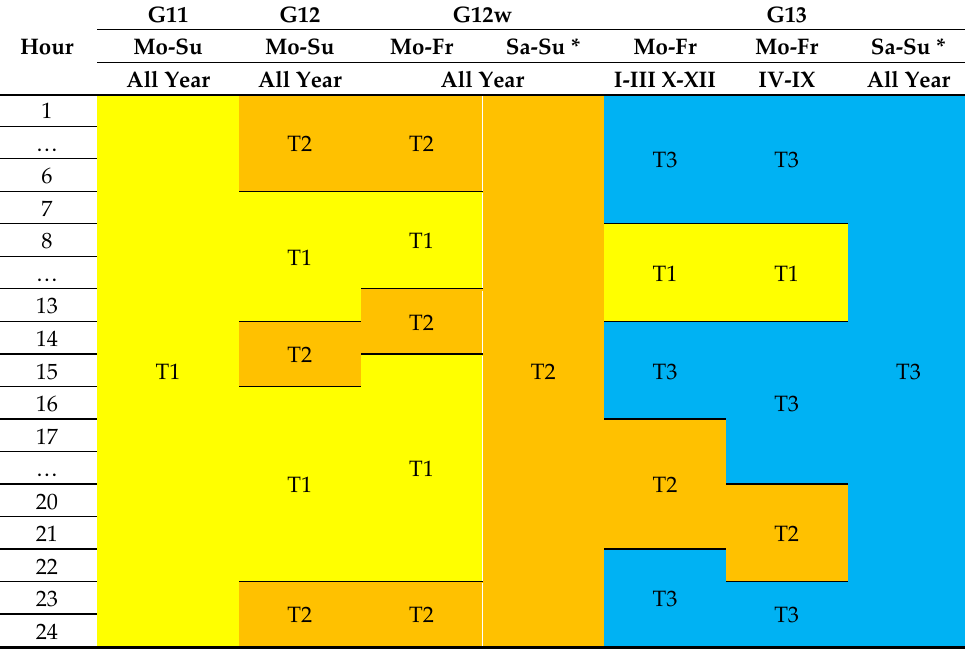
Table 2. Prices and structure of energy imported in G13 tariff zones in four year period.